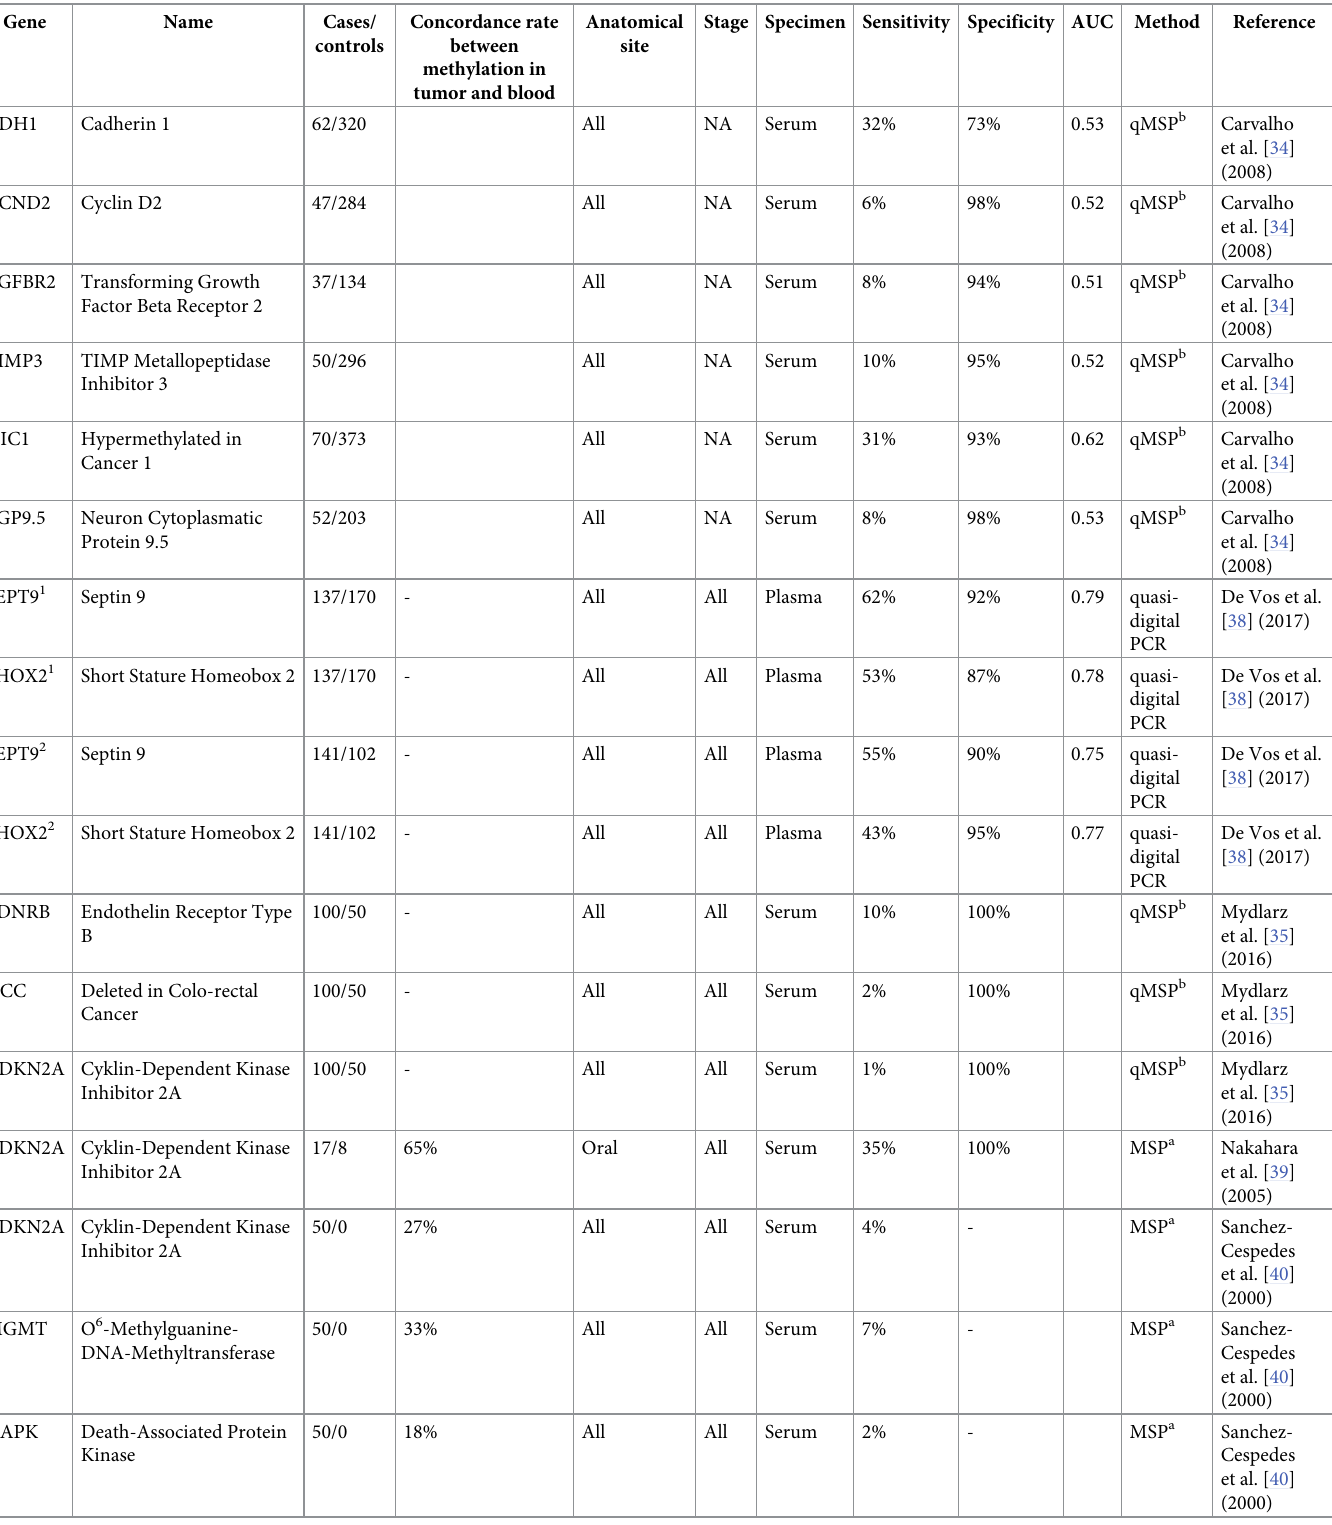
Table 1. Diagnostic value of DNA methylation in plasma or serum.